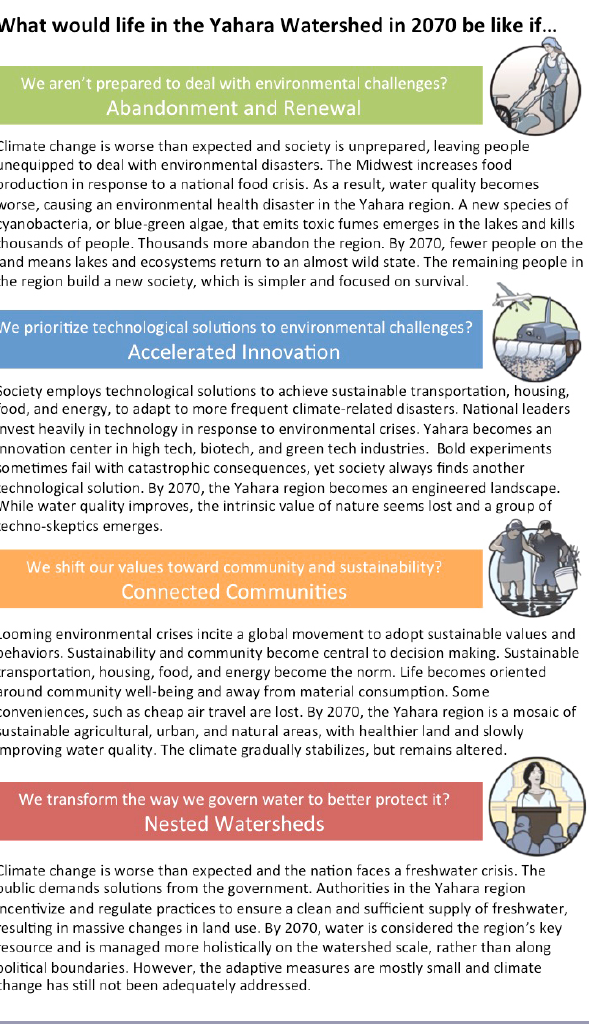
Fig. 2 . Yahara 2070 scenarios. See https://wsc.limnology.wisc. edu/yahara2070 to learn